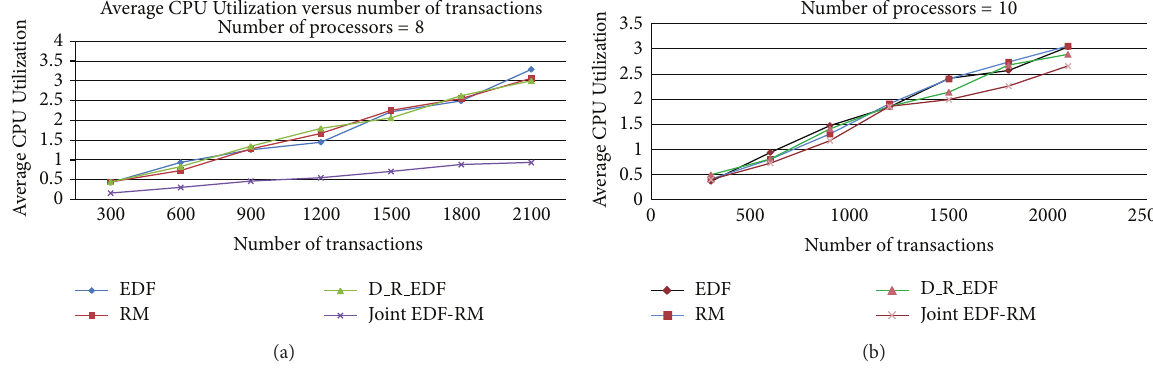
Figure 10: Average CPU Utilization versus number of transactions on 8 and 10